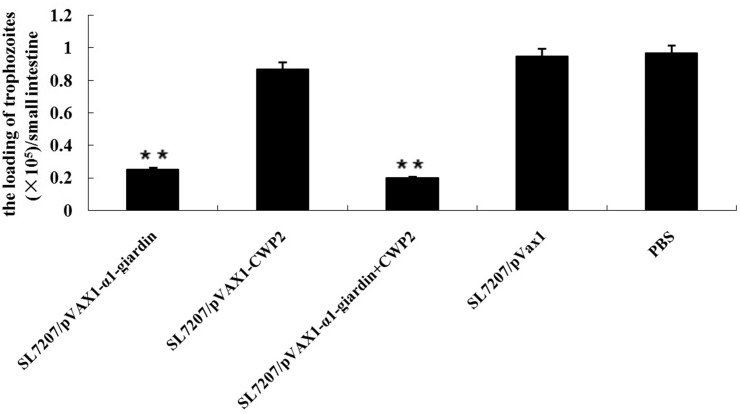
The average trophozoite counts in small intestine of mice of all groups on the fourth day after infection with 1×105 live Giardia trophozoites.Values shown for each group are the mean ± SE (n = 10) (*p<0.05,**p<0.01).